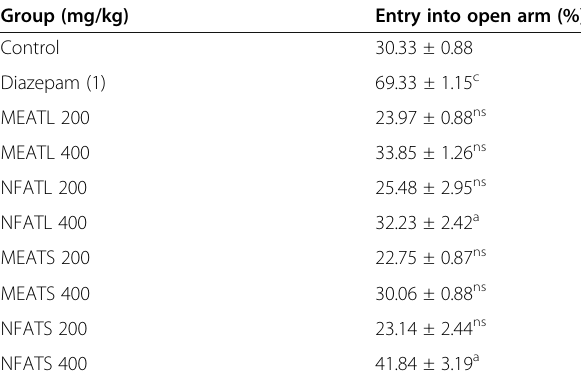
Table 1 Anxiolytic activity of different extract of A. trilobata on elevated plus-maze test